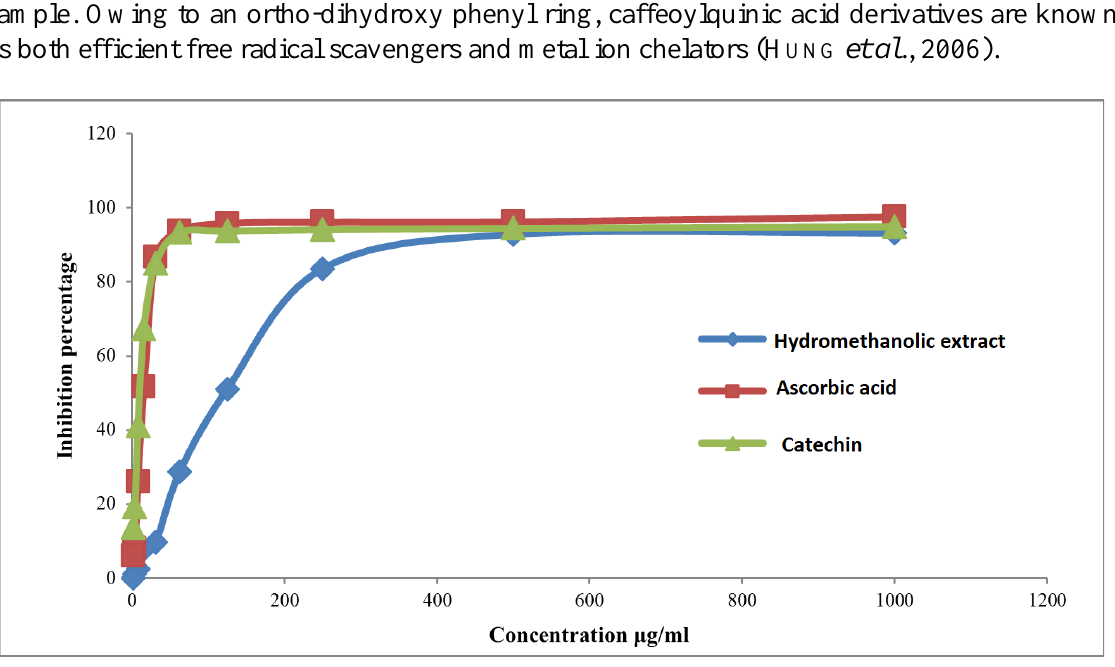
Figure 2. Antioxidant power tested by the DPPH radical scavenging method of hydromethanolic extract from Adiantum